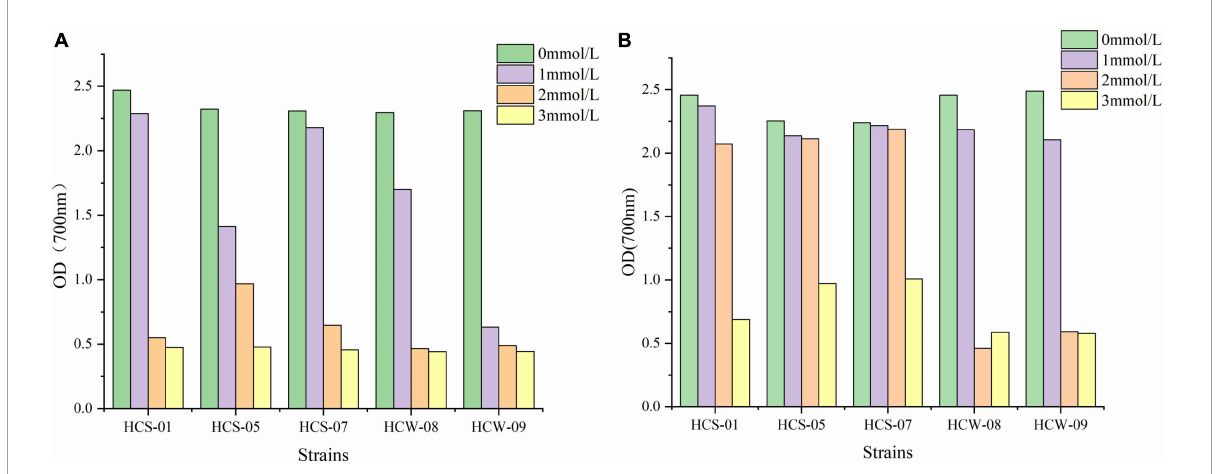
FIGURE1 Growth of strains at different concentrations of H 2 O 2 . (A) 12 h, (B) 24